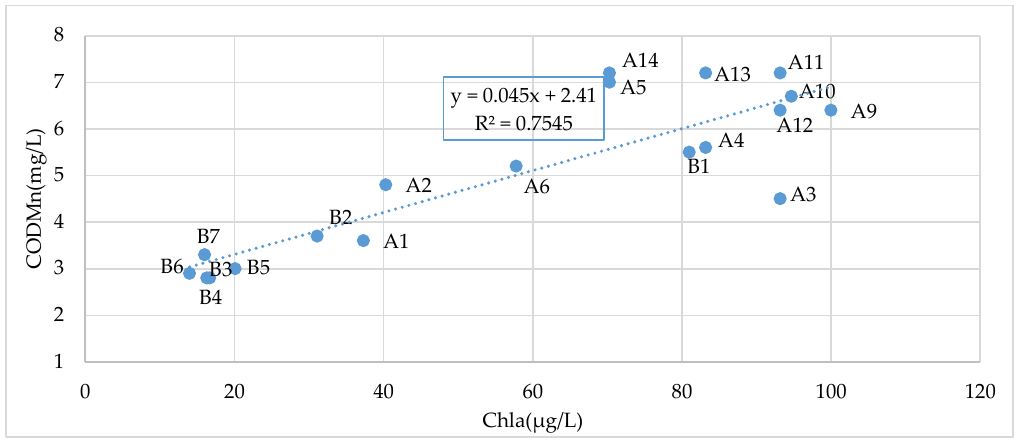
Figure 18. Chla and COD Mn concentrations of the sampling sites.